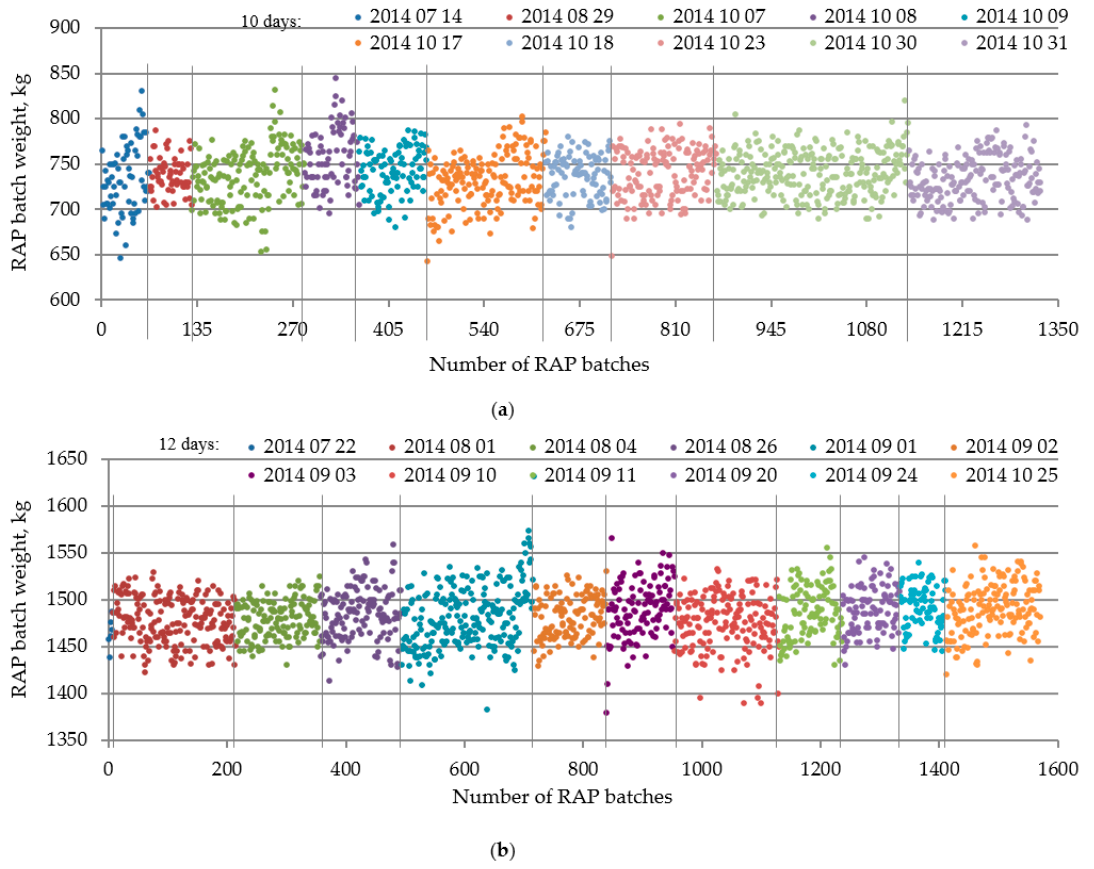
Figure 6. Distribution of RAP separate batch masses. When its job mix formula (JMF) is as follows: ( a )—750 kg; ( b )—1500 kg.